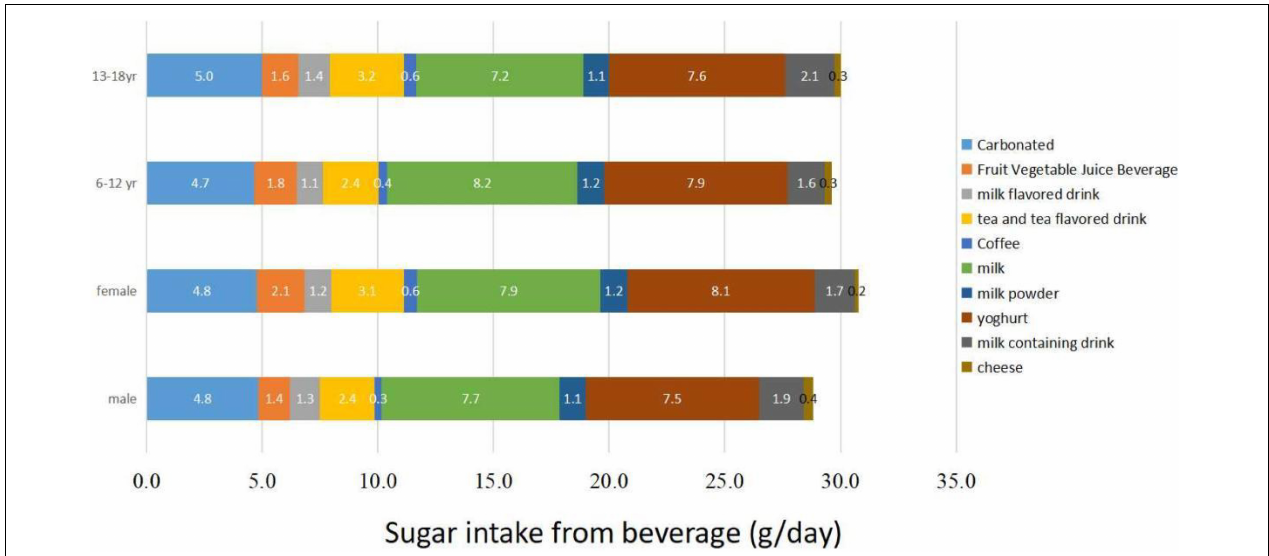
FIGURE 3 | Beverage sources of sugar in different age and gender